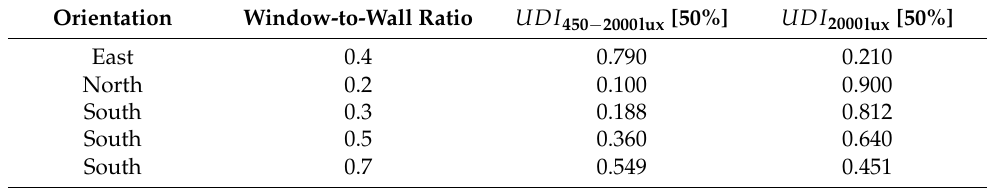
Table 10. The weights of UDI 450 − 2000lux [ 50% ] and UDI 2000lux [50%] in each orientation room.